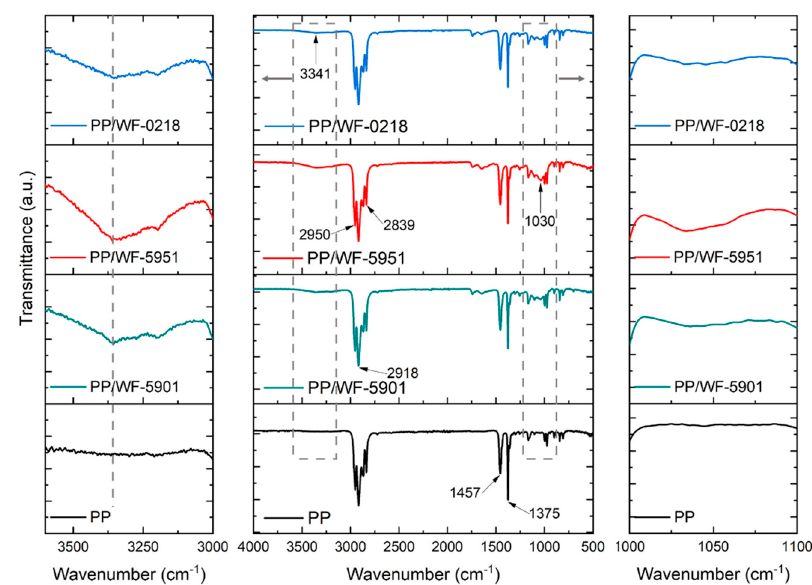
Figure 1. FTIR spectra of PP and PP/WF composites. Enlarged regions are to the left and right of the complete spectra.